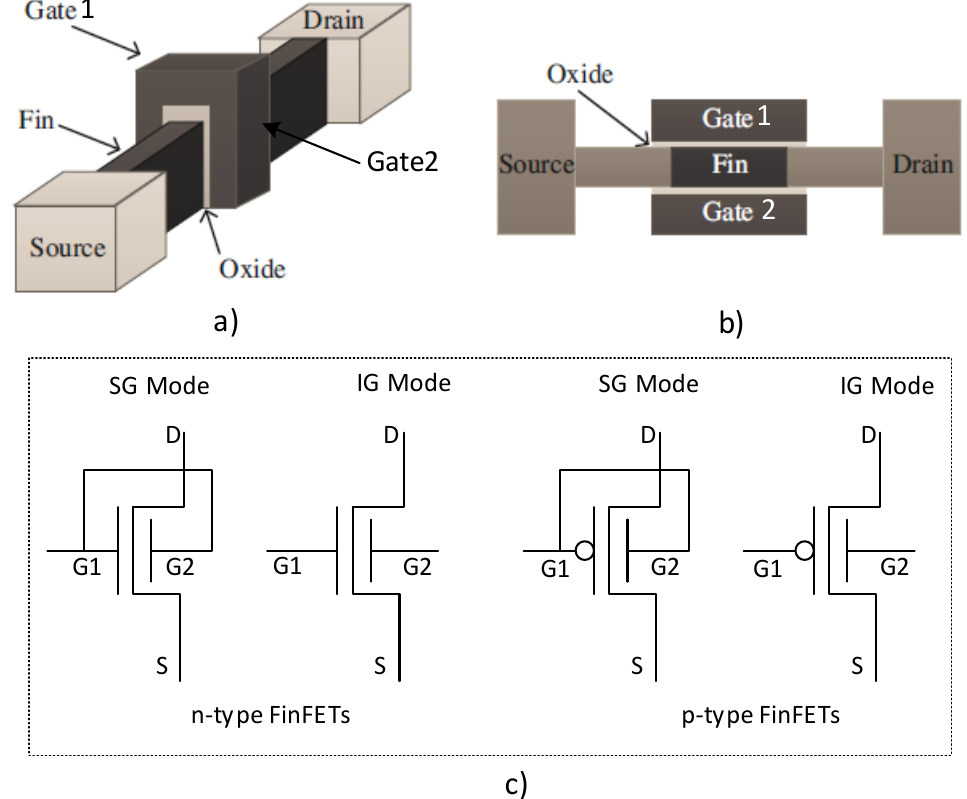
Figure 3. FinFET model and schematic: ( a ) three-dimensional structure, ( b ) cross-sectional top view, and ( c ) schematic symbol (modified from [42]).